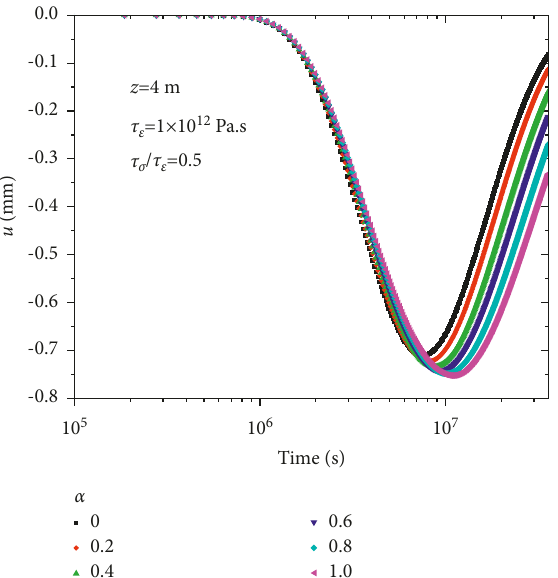
Figure 8: Influence of the order of the fractional derivative on displacement when τ